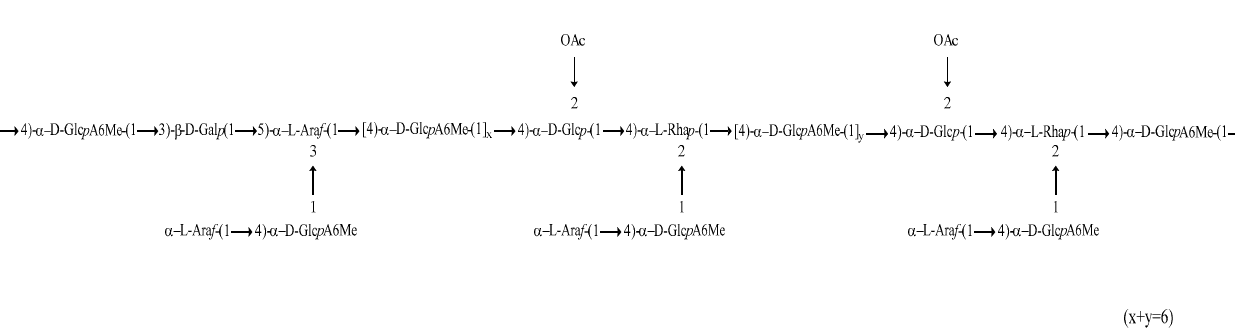
Figure 13. The possible repeat unit of LRP-S2A.